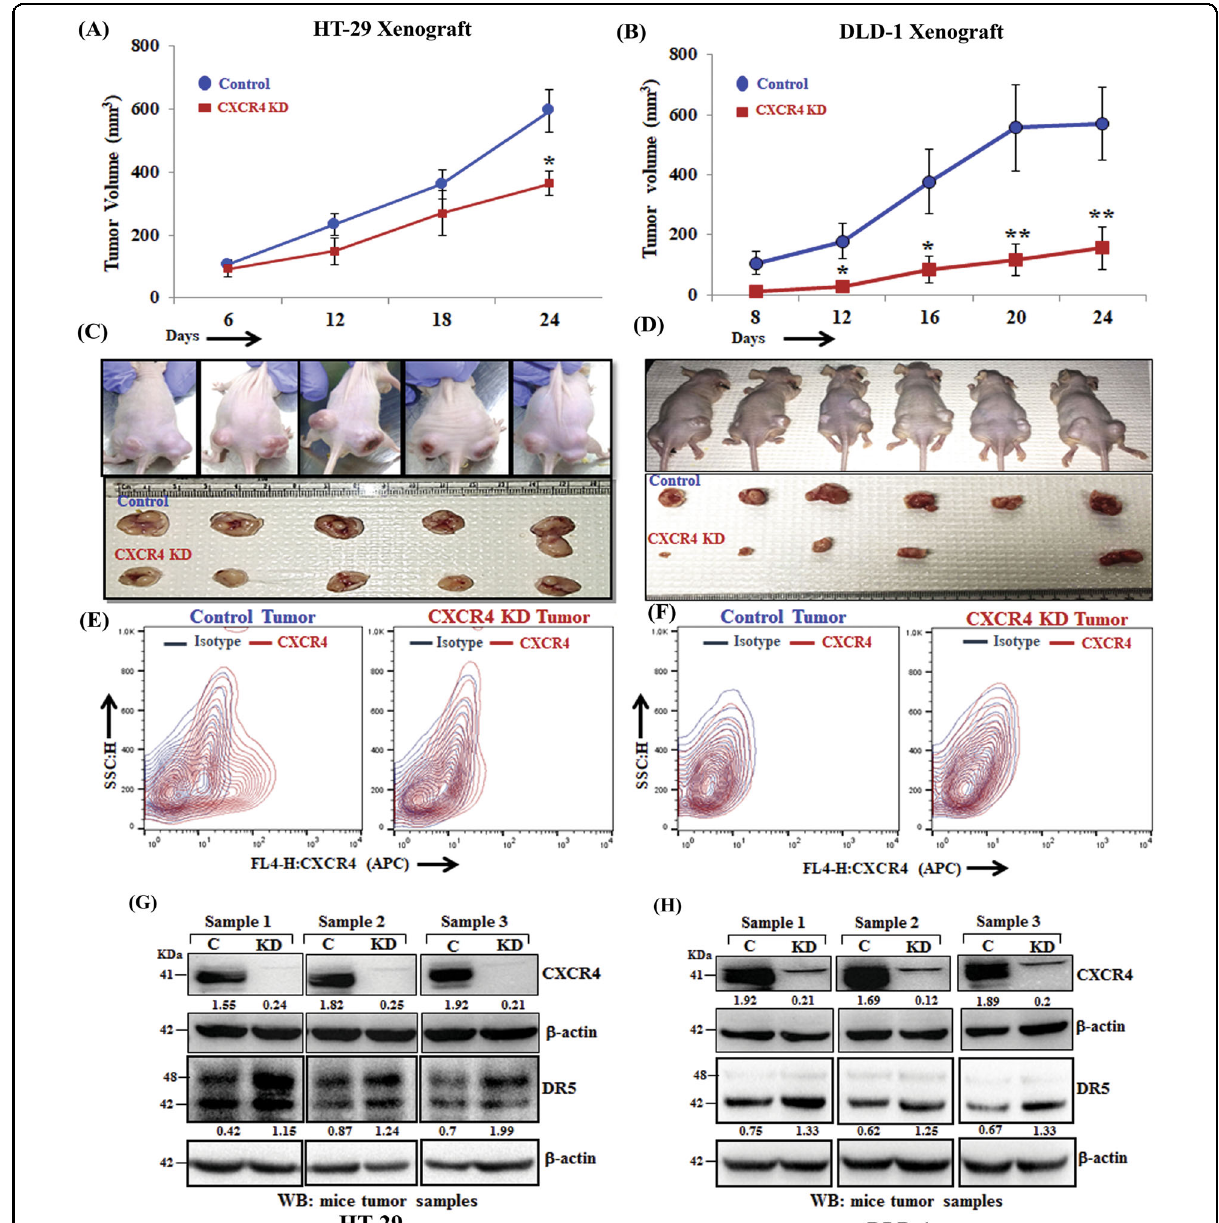
Fig. 5 CXCR4 protein knockdown results in compromised tumor growth and DR5 overexpression in vivo. In total, 2 × 10 6 stable control (HT- 29 and DLD-1) or CXCR4 knockdown (HT-29 and DLD-1) cells in 100 μ l PBS were injected subcutaneously in the fl anks of the right or left hind leg of 4 – 6 weeks old Crl: CD1-Foxn1 nu mice respectively. Tumor volumes were measured after regular intervals by using a caliper. Growth curves for HT-29 ( A ) and DLD-1 ( B ) are shown for tumors generated from control and CXCR4 knockdown cells; points are indicative of the average value of tumor volume ± SE ( n = 5 for HT-29, n = 6 for DLD-1); * p < 0.05 compared to control tumors. C , D Upper panels represent images of tumor-bearing mice, control (right fl ank), and CXCR4 knockdown (left fl ank). Mice were sacri fi ced, and the respective tumors from HT29 ( C ) and DLD-1 ( D ) were harvested and shown in photographs in lower panels. Single cells from respective control and CXCR4 knockdown HT-29 ( E ) and DLD-1 ( F ) were harvested and stained with either APC-conjugated anti-human CXCR4 (CD184) or isotype control antibodies, and contour FACS plots analyzed cell surface expression of CXCR4. Harvested tumors generated from control and CXCR4 knockdown cells HT-29 ( G ) and DLD-1 ( H ) were subjected to Western blot analysis for CXCR4 and DR5. β -actin was used as protein loading control. Western Blot densitometric quanti fi cation numbers are shown above the loading control blot of all immunoblot